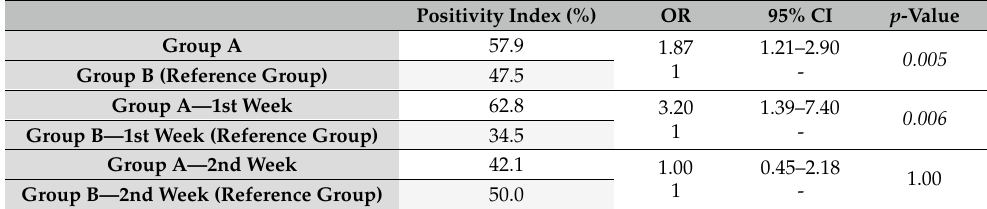
Table 3. Positivity indexes and odds ratios for subjects tested for influenza A.